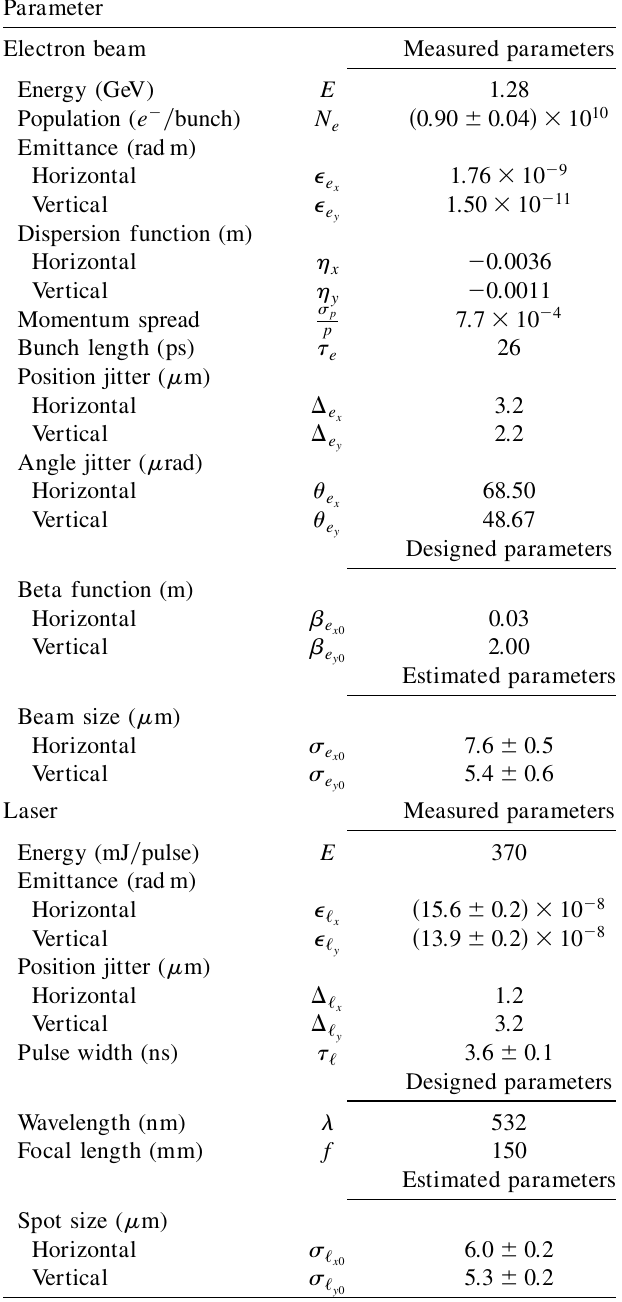
TABLE I. Parameters of the e (cid:1) and laser beams. Parameter Electron